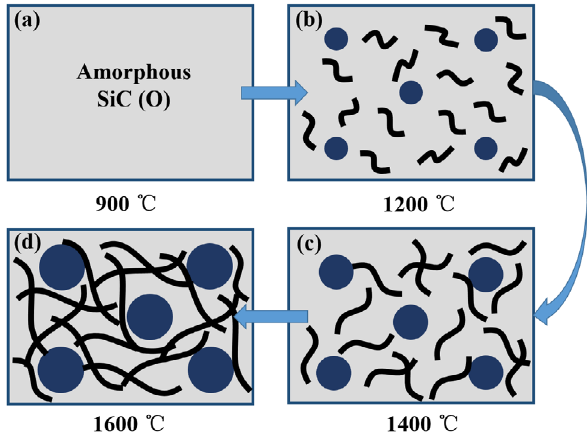
Fig. 6 Schematic illustration of the microstructural evolution of carbon-rich SiC